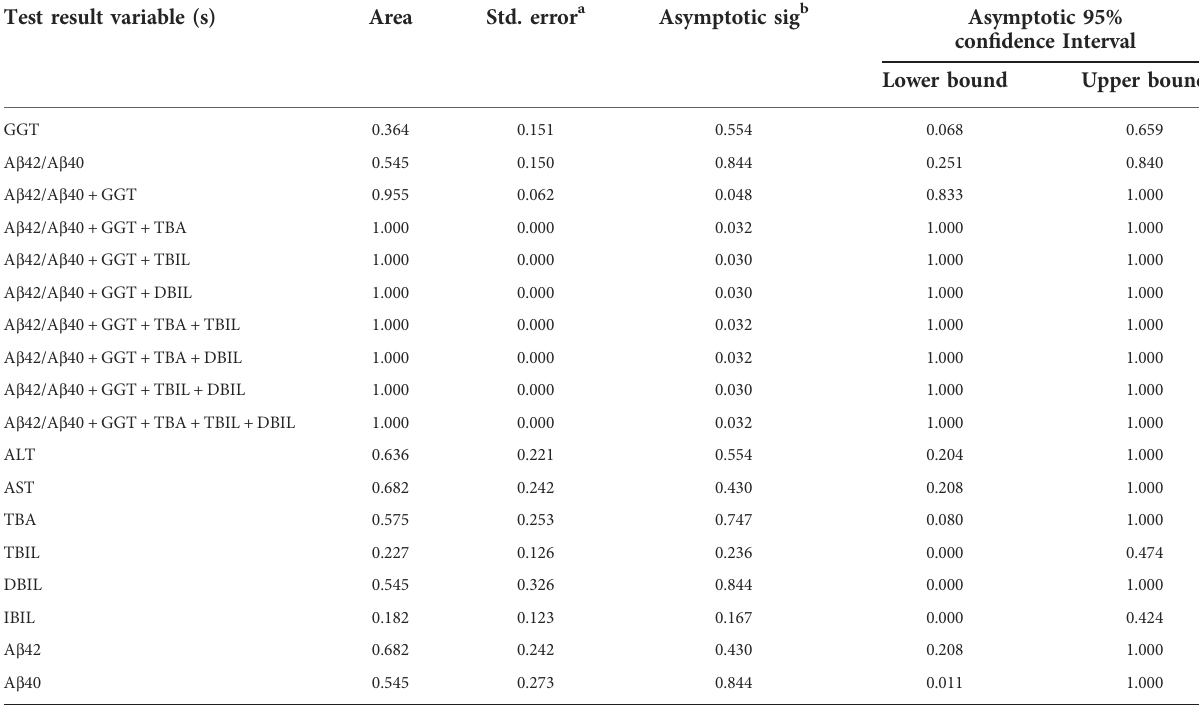
TABLE 4 Area under curve of A β 42/A β 40 and hepatic function parameters either alone or in combinations for the diagnosis of biliary